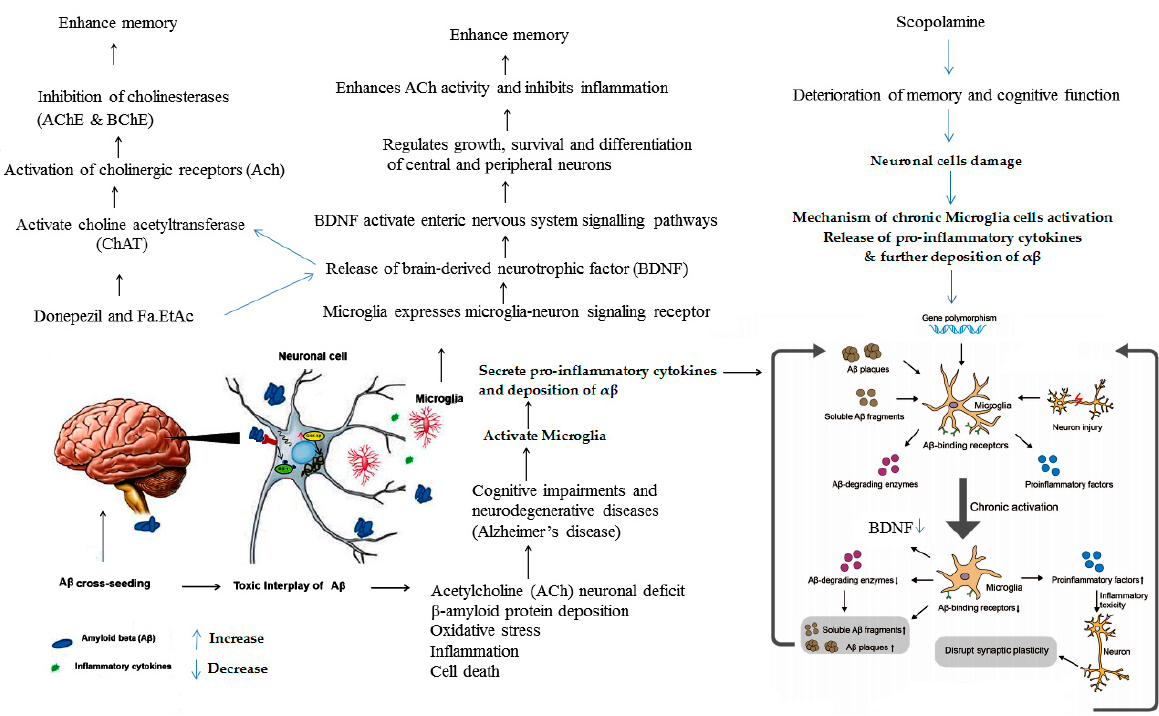
Figure 9. Mechanistic overview of Fa.EtAc as nootropic on the responsible factors involved in the aetiology of neurodegen- erative diseases.